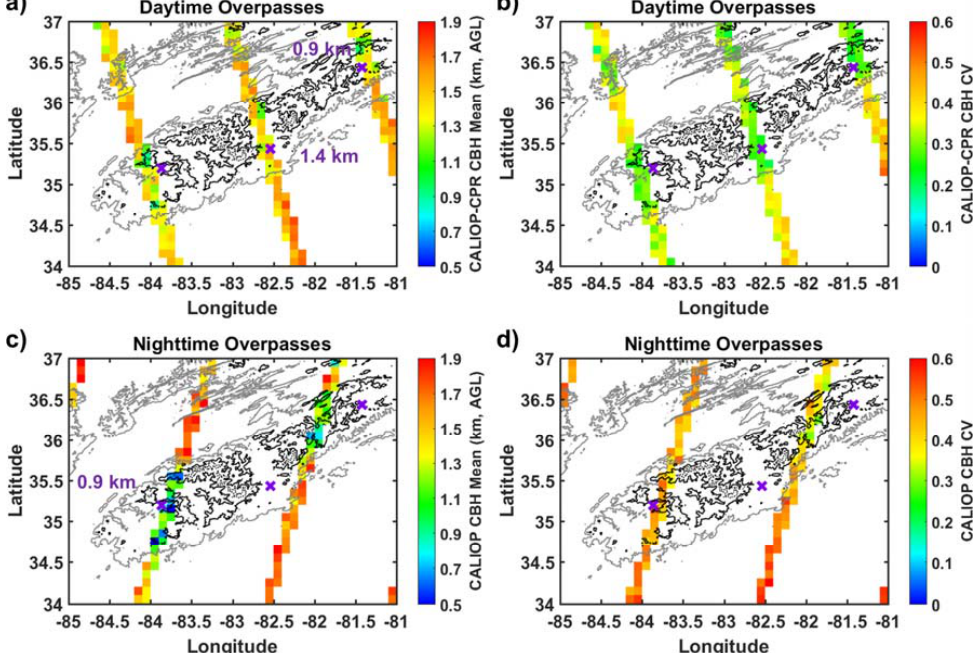
Figure 11. ( Top ) Mean ( a ) of CALIOP-CPR CBHs (km, AGL) for low-level clouds and fog (LLCF, merged CBH < 4 km MSL) and the corresponding coefficient of variance (CV; b ) in each grid box (0.1° × 0.1°) for daytime overpasses. ( Bottom ) Mean ( c ) of CALIOP CBHs (km, AGL) for LLCF (CALIOP CBH < 4 km MSL) and the corresponding CV ( d ) in each grid box (0.1° × 0.1°) for nighttime overpasses. Contour lines denote terrain elevation of 500 m (solid grey), 1000 m (solid black) and 1500 m (dotted black). Note the three ground ceilometer sites (from left to right: KRHP, KAVL, KGEV) are marked by purple crosses and the numbers next to them represent mean ceilometer CBHs around satellite overpass